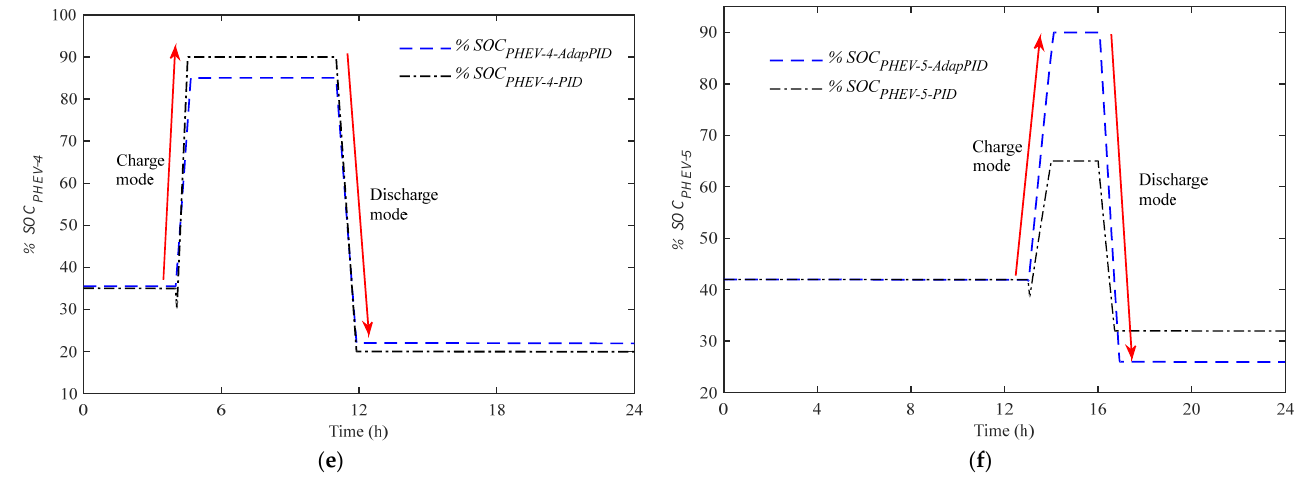
Figure 7. % SOCs of ( a ) BSS ( b ) PHEV ‐ 1 ( c ) PHEV ‐ 2 ( d ) PHEV ‐ 3 ( e ) PHEV ‐ 4 ( f ) PHEV ‐ 5 .